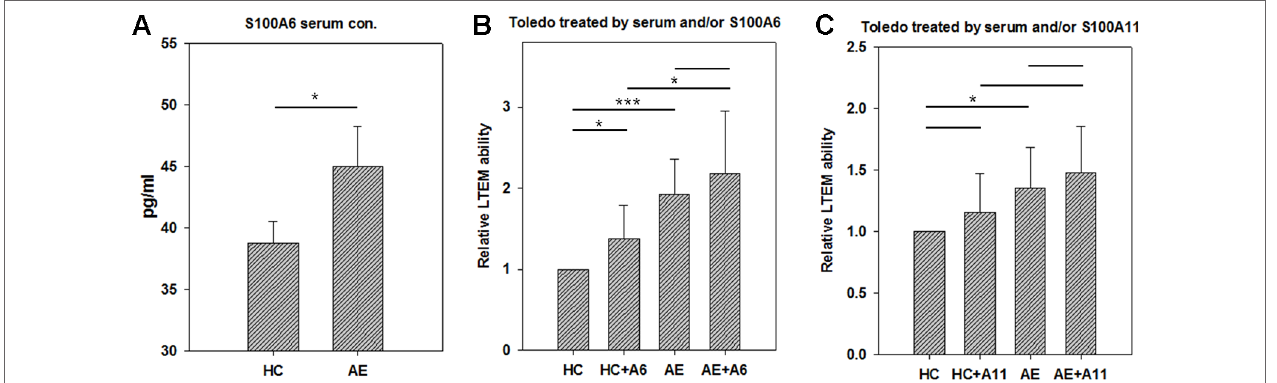
FigUrE 4 | The results of in vitro LTEM assays on Toledo cells with serum and/or S100A recombinant protein treatment. To investigate whether serum and S100A proteins promote in vitro Toledo cell infiltration, we conducted AE-specified LTEM assays by making the BBB endothelial layer with hCMEC cells. (A) We conducted ELISA to examine serum level of S100A6 in four HC and five AE subjects. (B) The LTEM assay result of S100A6 (N = 4). (c) The LTEM assay result of S100A11 (N = 5). Data was presented as mean ± S.D. * and *** denoted p-value < 0.05 and 0.001,